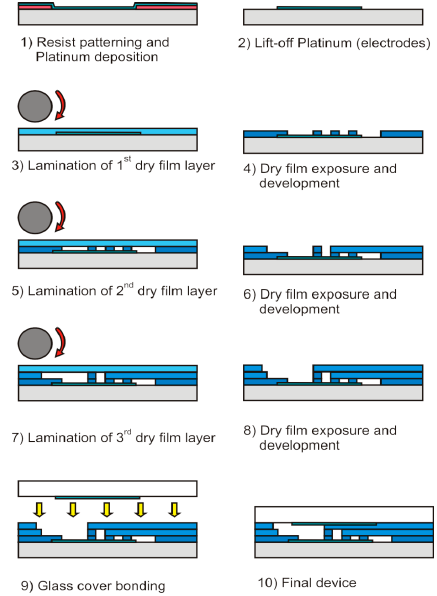
Figure 2. Fabrication process. Sequence of steps from the patterning of the electrodes to the glass cover